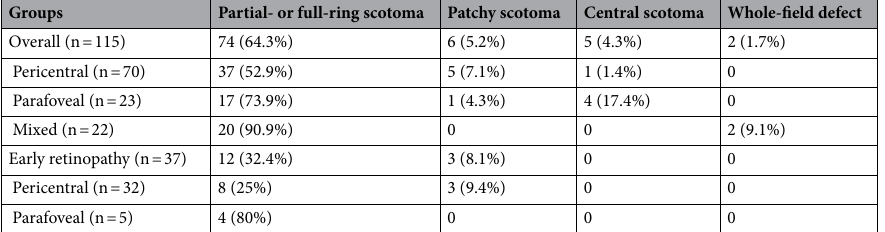
Table 2. Typical patterns of scotoma on the Humphrey 10-2 standard automated perimetry in subgroups according to the pattern among overall patients and those with early retinopathy.